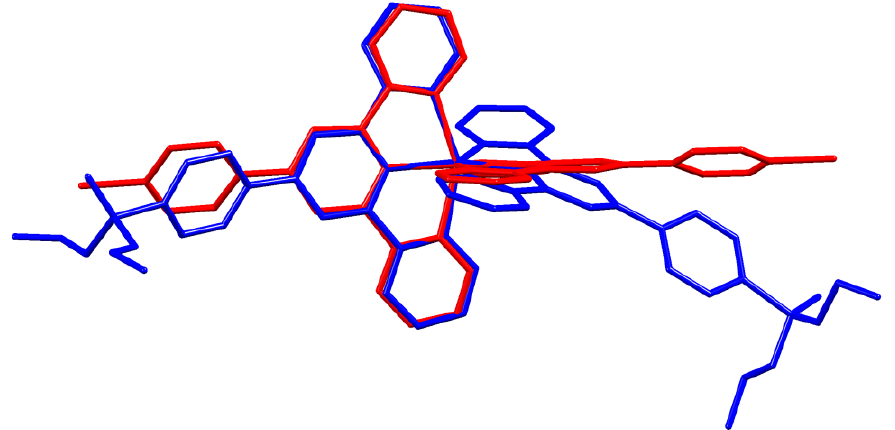
Figure 6. Overlay of the structures of the [Zn( 1 ) 2 ] 2+ (red) and [Zn( 2 ) 2 ] 2+ (blue) cations (H atoms omitted). Pairs of atoms Zn1, N2, N5, and N1 were superimposed to within ±0.13 Å .